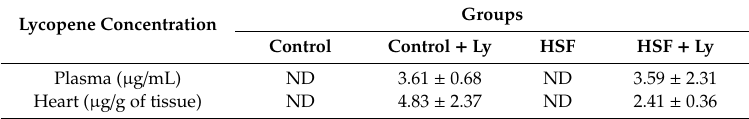
Table 1. Lycopene